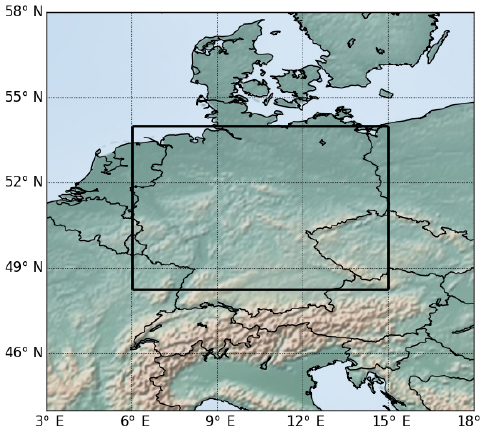
Figure 1. Domain over Germany used in this